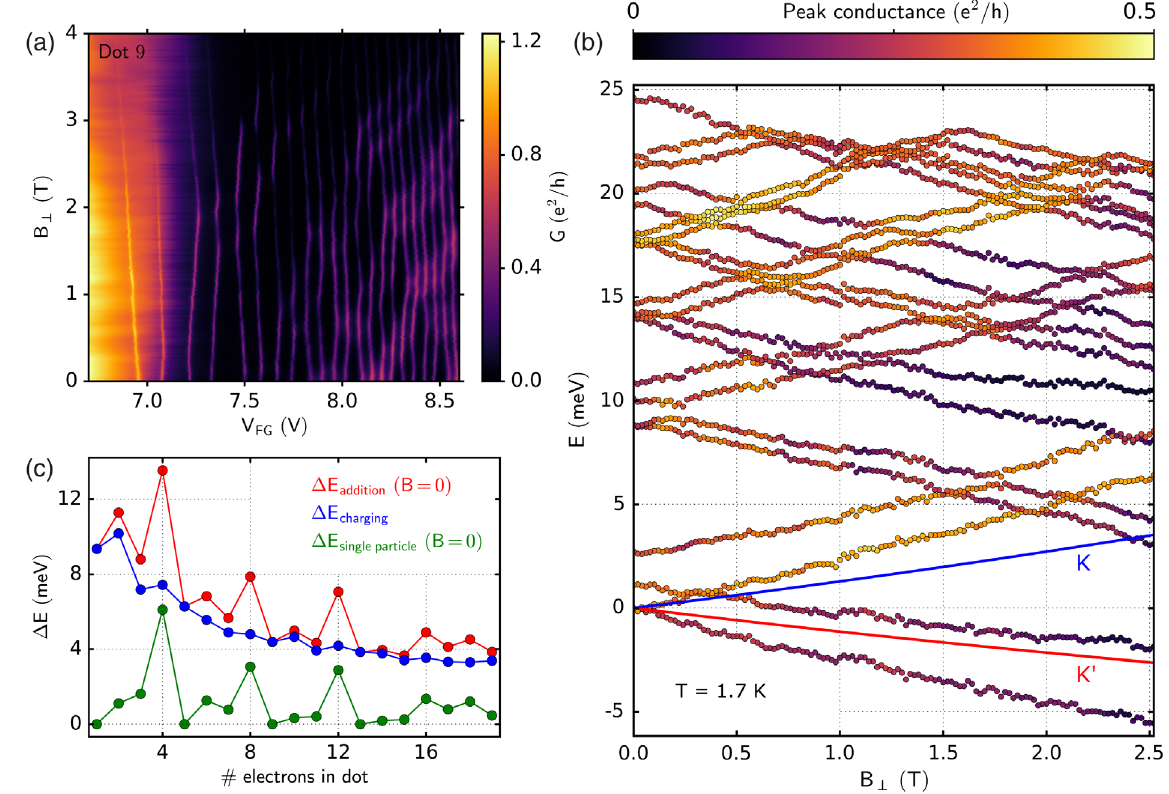
FIG. 3. (a) Conductance map in a perpendicular magnetic field for QD 9 in the electron regime. (b) Single particle energy level dispersion for QD 9 with perpendicular magnetic field B ⊥ extracted from Fig. 3(a). Blue and red solid lines are the result of theoretical calculations of the lowest energy levels. (c) Addition (red), charging (blue), and single particle energy (green) as a function of the QD occupation extracted from Fig.